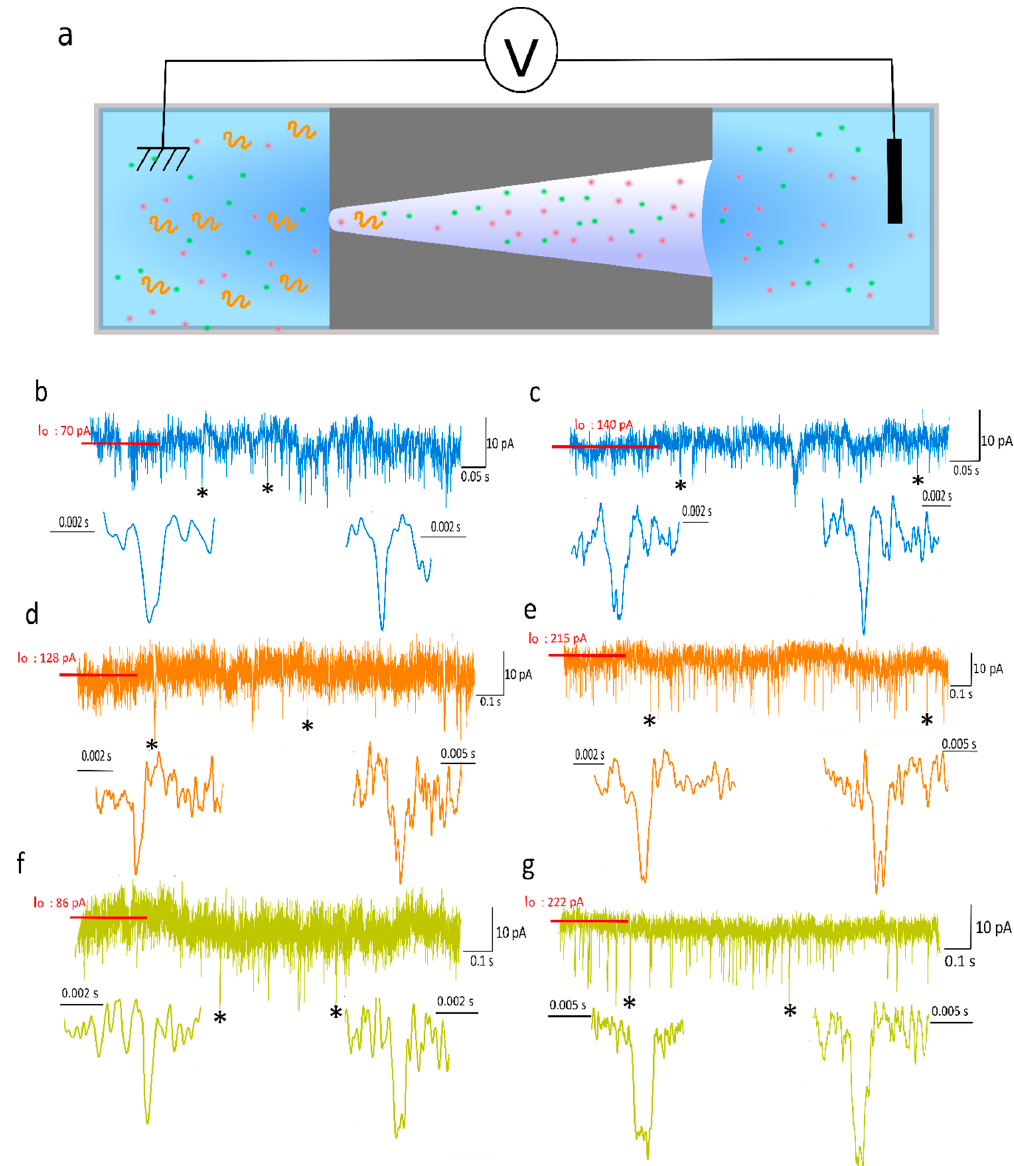
Figure 1. ( a ) Sketch of DNA sensing using conical nanopore. Examples of current traces and zooms of current blockade recorded for A 10 /T 10 at ( b ) 250 mV and ( c ) 500 mV, A 40 /T 40 at ( d ) 250 mV and ( e ) 500 mV, T 40 at ( f ) 250 mV and ( g ) 500 mV. The symbol * identifies the examples of current blockade zoom below each trace. The current traces were obtained using pore 1 d t = 3 nm, d b = 200 nm. In Figure 2 are reported the distribution histograms of Δ I/I 0 obtained for the A 10 /T 10 , A 40 /T 40 and T 40 at a voltage of 500 mV using pore 1 under KCl 2M. These distributions are centered at similar values for the three samples: 0.085, 0.093 and 0.066 (another center of distribution is observed at 0.128) for A 10 /T 10 , A 40 /T 40 and T 40 , respectively. The Δ I/I 0 distributions of the current blockade recorded at